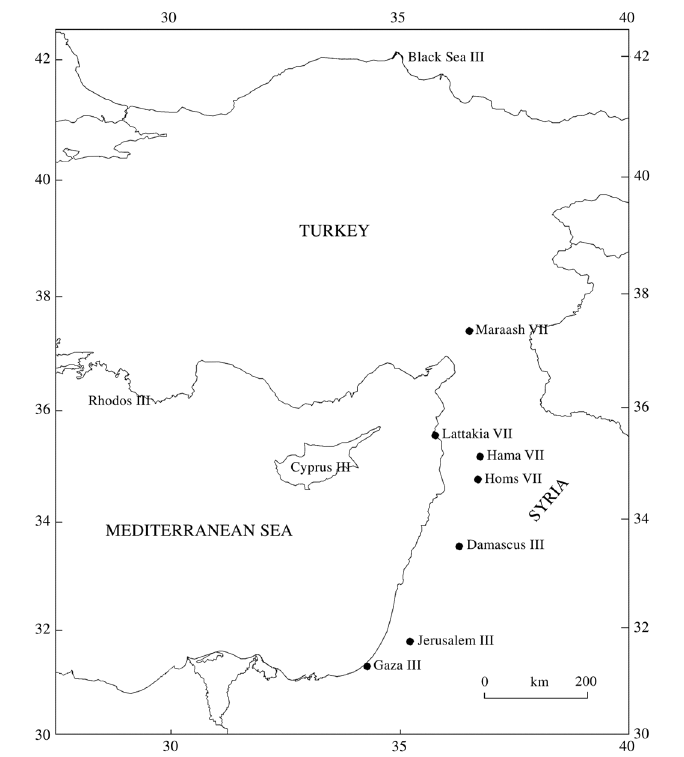
Fig. 13. Map of intensity distribution for August 13, 1822 earthquake.